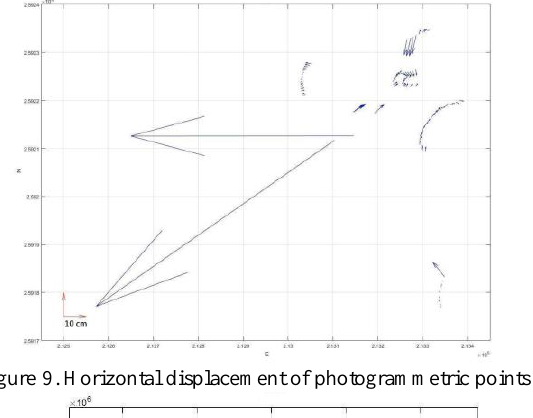
Figure 9. Horizontal displacement of photogrammetric points.